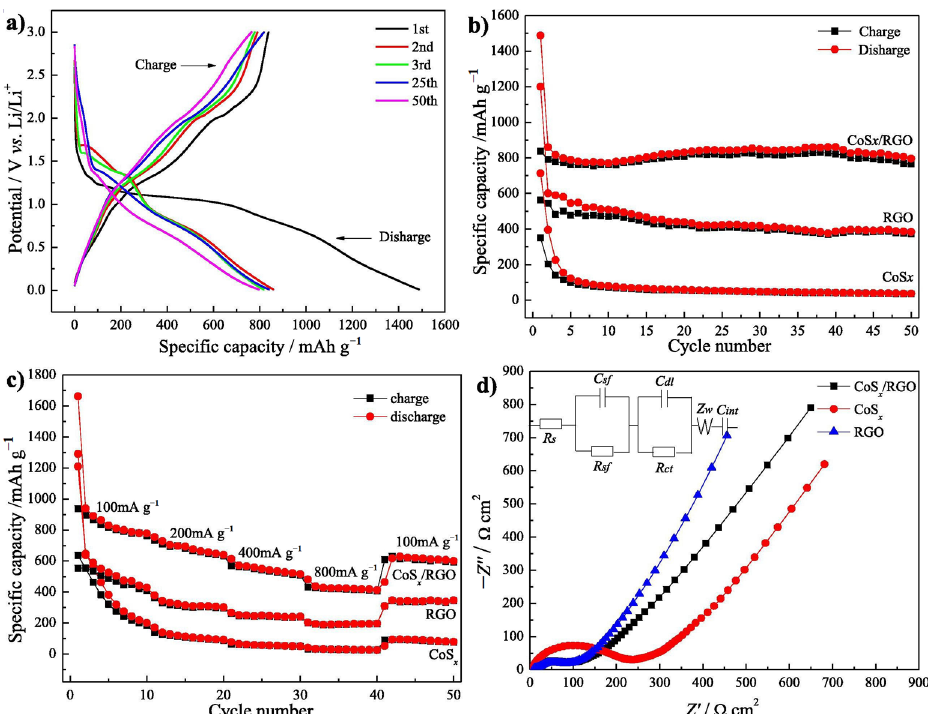
Figure 10. ( a ) GCD curves of CoS x /RGO; ( b ) Cycling performance of the samples; ( c ) Rate capability and ( d ) Nyquist plots of CoS x , RGO and CoS x /RGO. Reproduced with permission from Junsheng Zhu, Embedding cobalt sulfide in reduced graphene oxide for superior lithium-ion storage; published by Elsevier, 2019 [82].